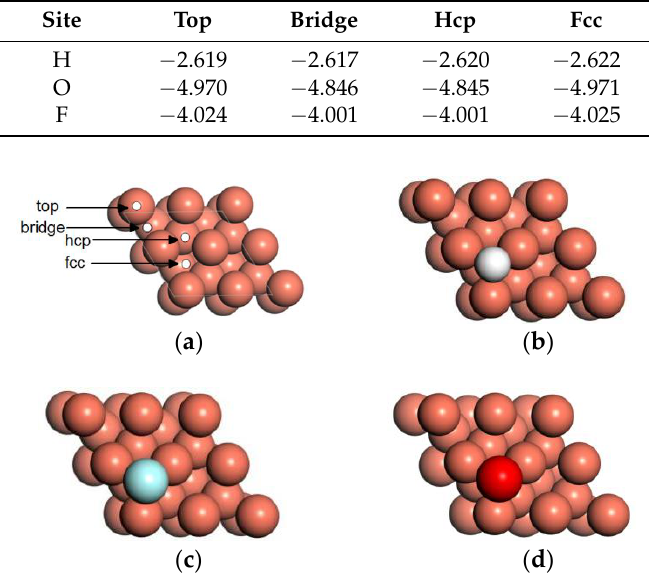
Figure 6. Stable adsorption configuration of adatom on Cu(111) surface: ( a ) surface adsorption sites of Cu(111), ( b ) H, ( c ) F, and ( d ) O. Cu(111), ( b ) H, ( c ) F, and ( d ) O.